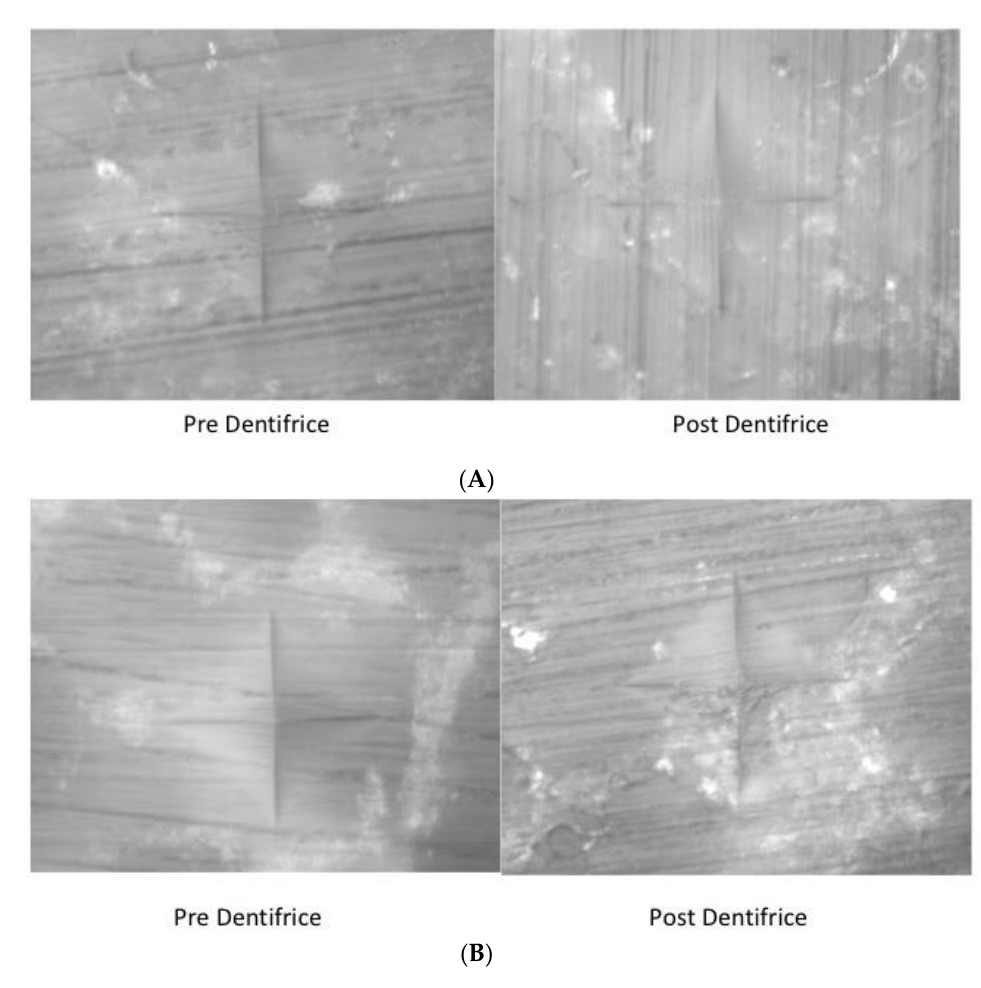
Figure 1. Vickers indentations for hardness testing before and after dentifrice exposure in conven- tional resin ( A ) and bulk-fill resin ( B ).